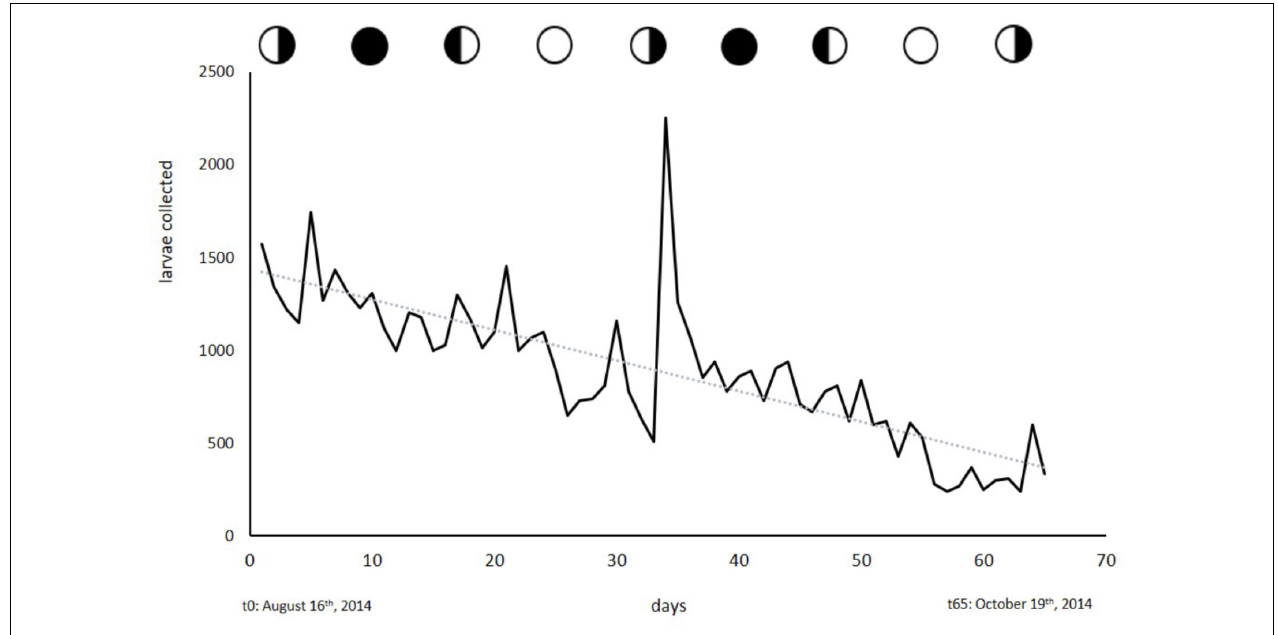
FIGURE 6 | Larvae collected from the broodstock of 243 colonies. Circles indicate moon phases. Collection started on August 16th, 2014 and ended on October 19th, 2014.